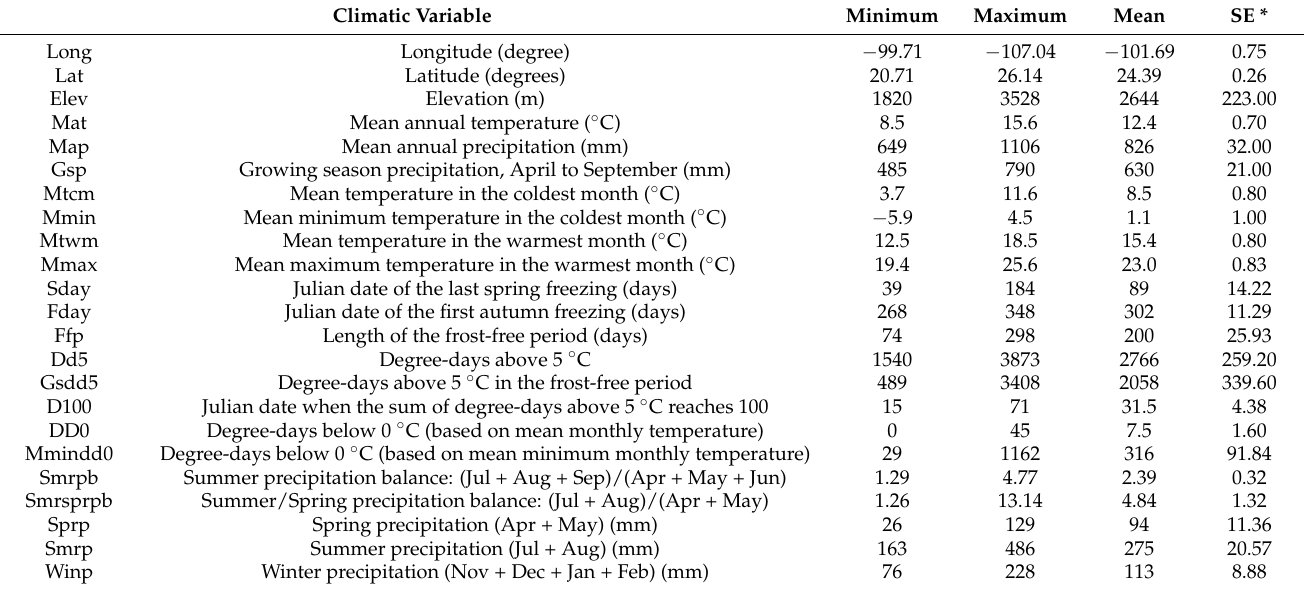
Table 2. Mean values of climate variable used for the environment–phenotype associations tests (* SE = standard error; data of Picea chihuahuana from [20] and of P. martinezii and P. mexicana from [21] for the time period